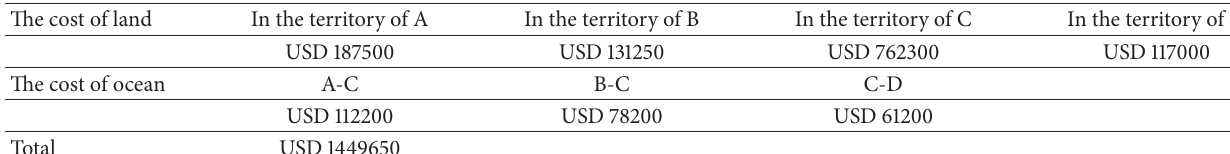
Table 5: Simulation results of freight cost in Scheme